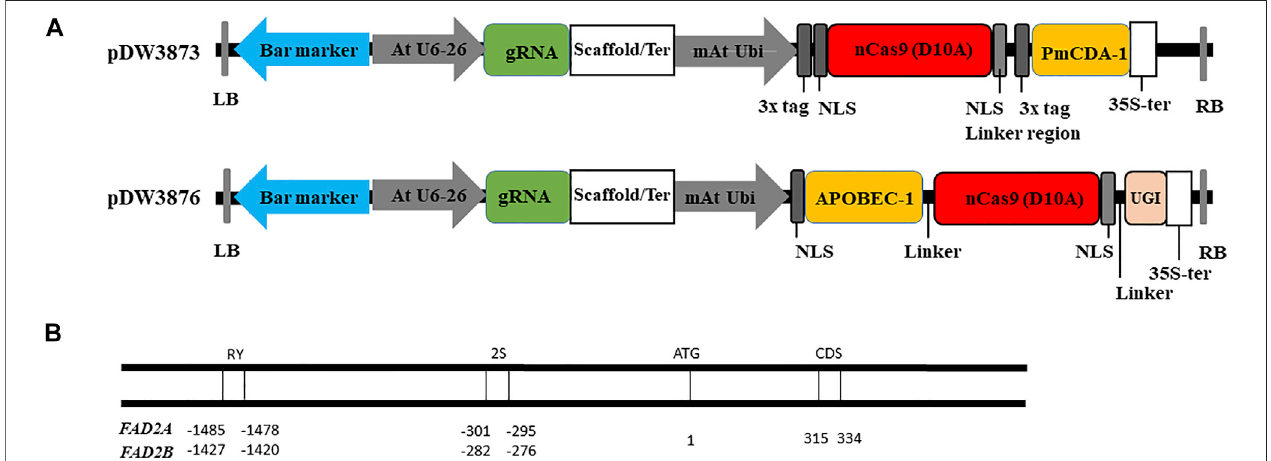
FIGURE1| Vectorsandtargetsusedforbaseeditinginthisstudy. (A) .ConstructionofvectorswithdeaminasePmCDA-1andAPOBEC-1. (B) .Targetsselectedin the homeologous gene FAD2A and FAD2B .